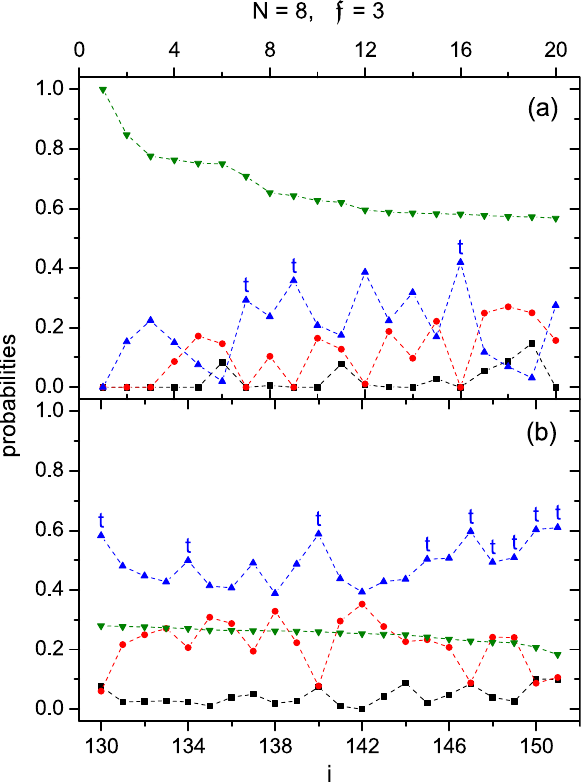
Figure 2. P (cid:31) against j for the case of H (cid:31) with N = 8 and f = 3 . Probabilities, ( a ) for the states with j ≤ 20 , ( b ) for j ≥ 131 . The symbols in black square, red circle, blue triangle, and olive reverse-triangle are for (cid:31) = 0, 2, 4 , and 6, respectively. All the t-states (the highest one of an S -group) are marked with a ’t’ (except those with multiplicity one, which happens when j = 1, 2, 3 , and 142).